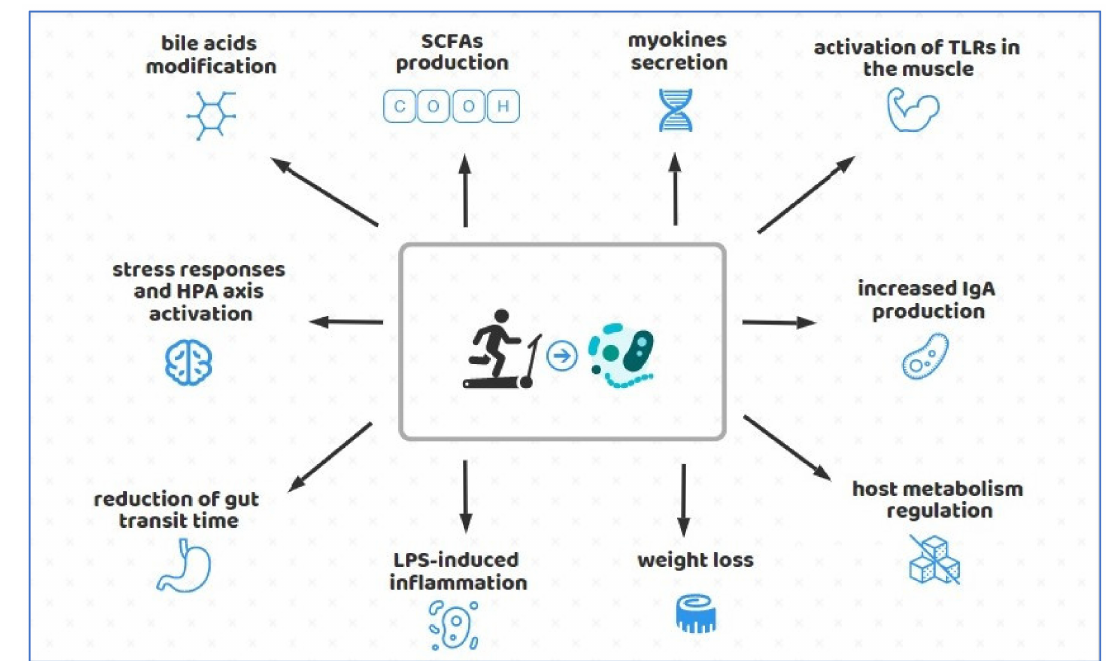
Figure 1. Schematic representation of the effect of physical activity on gut microbiota. Physical activity could alter the gut microbiota through several pathways, as depicted in figure. Specifically, the mechanisms involved in the effects are the pathways involved in modification of bile acid profiles, SCFAs production, myokines secretion, activation of Toll-Like Receptors (TLRs) in the muscle by LPS, increase IgA production, glucose homeostasis maintenance, HPA axis activation. Moreover, physical activity influence also weight loss, exercise-induced heat stress, reduction of gut transient